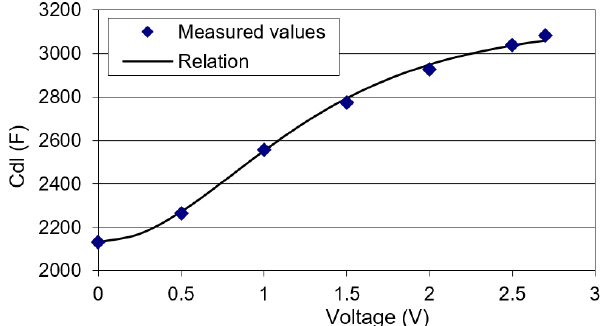
Figure 1. The capacitance evolution as a function of the voltage of a conventional supercapacitor [13].